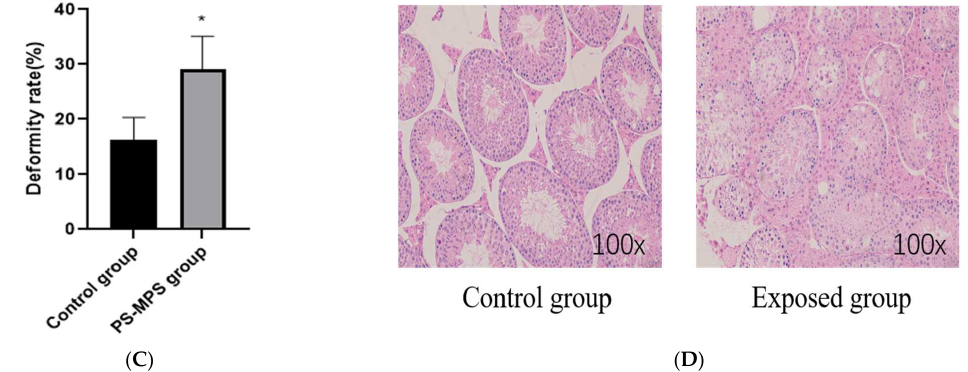
Figure 2. Sperm quality of mice and structure of the testis after exposure period. ( A ) Sperm survival; ( B ) Forward motion; ( C ) Deformity; ( D ) HE staining results of mice testicular tissue. The data are expressed as the mean ± SD (n = 8) and analyzed by dependent sample t -test. Note: * p < 0.05, indicates a statistically significant difference from the control.